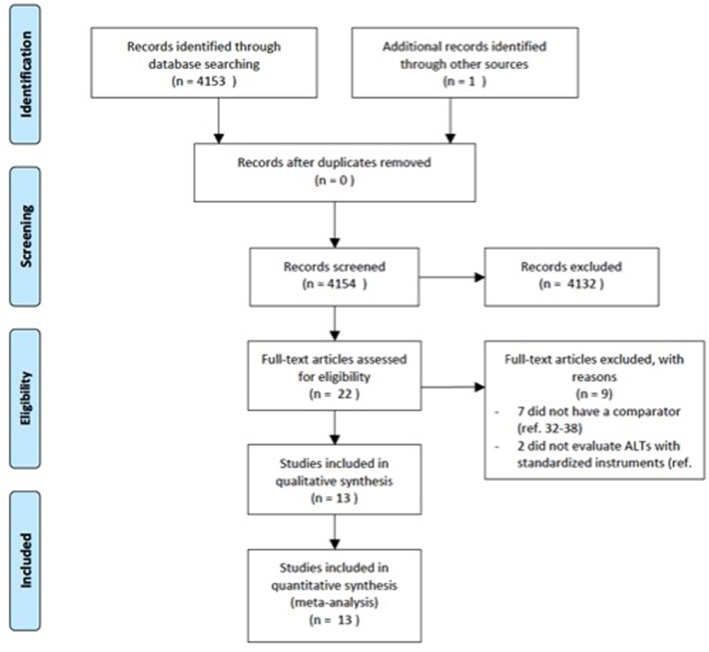
PRISMA flow diagram.